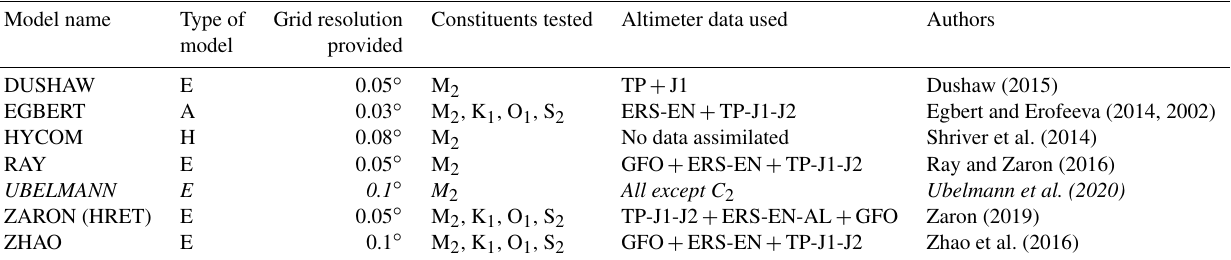
Table 1. List of the participating IT models. Most of the models are global models except one that is currently available in only two areas (Hawaii and Azores, noted in italic). E – empirical model; A – assimilative model; H – hydrodynamic model. Abbreviations used for altimeter missions: TP – TOPEX/Poseidon; J1 – Jason-1; J2 – Jason-2; EN – Envisat; GFO – GEOSAT Follow-On; C2 – CryoSat-2; AL –